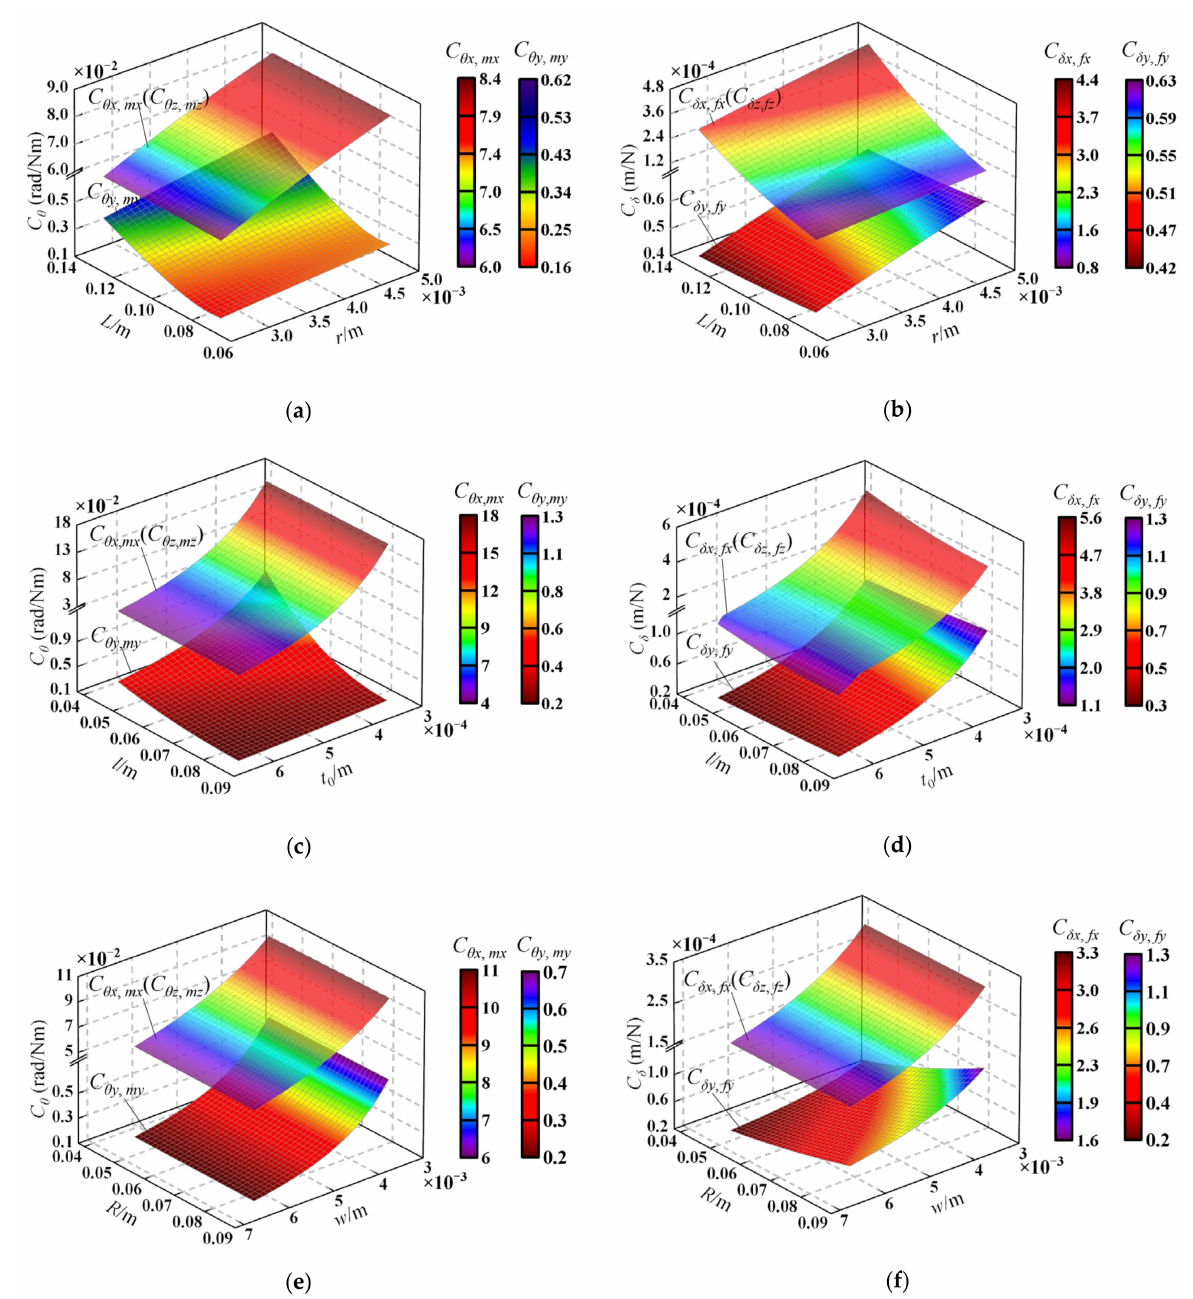
Figure 5. Compliance variation with the structure parameters of the flexure hinge and the scale parameters of the mechanism: ( a ) variation of C θ in terms of the parameters L and r ; ( b ) variation of C δ in terms of the parameters L and r ; ( c ) variation of C θ in terms of the parameters l and t 0 ; ( d ) variation of C δ in terms of the parameters l and t 0 ; ( e ) variation of C θ in terms of the parameters R and w ; ( f ) variation of C δ in terms of the parameters R and w